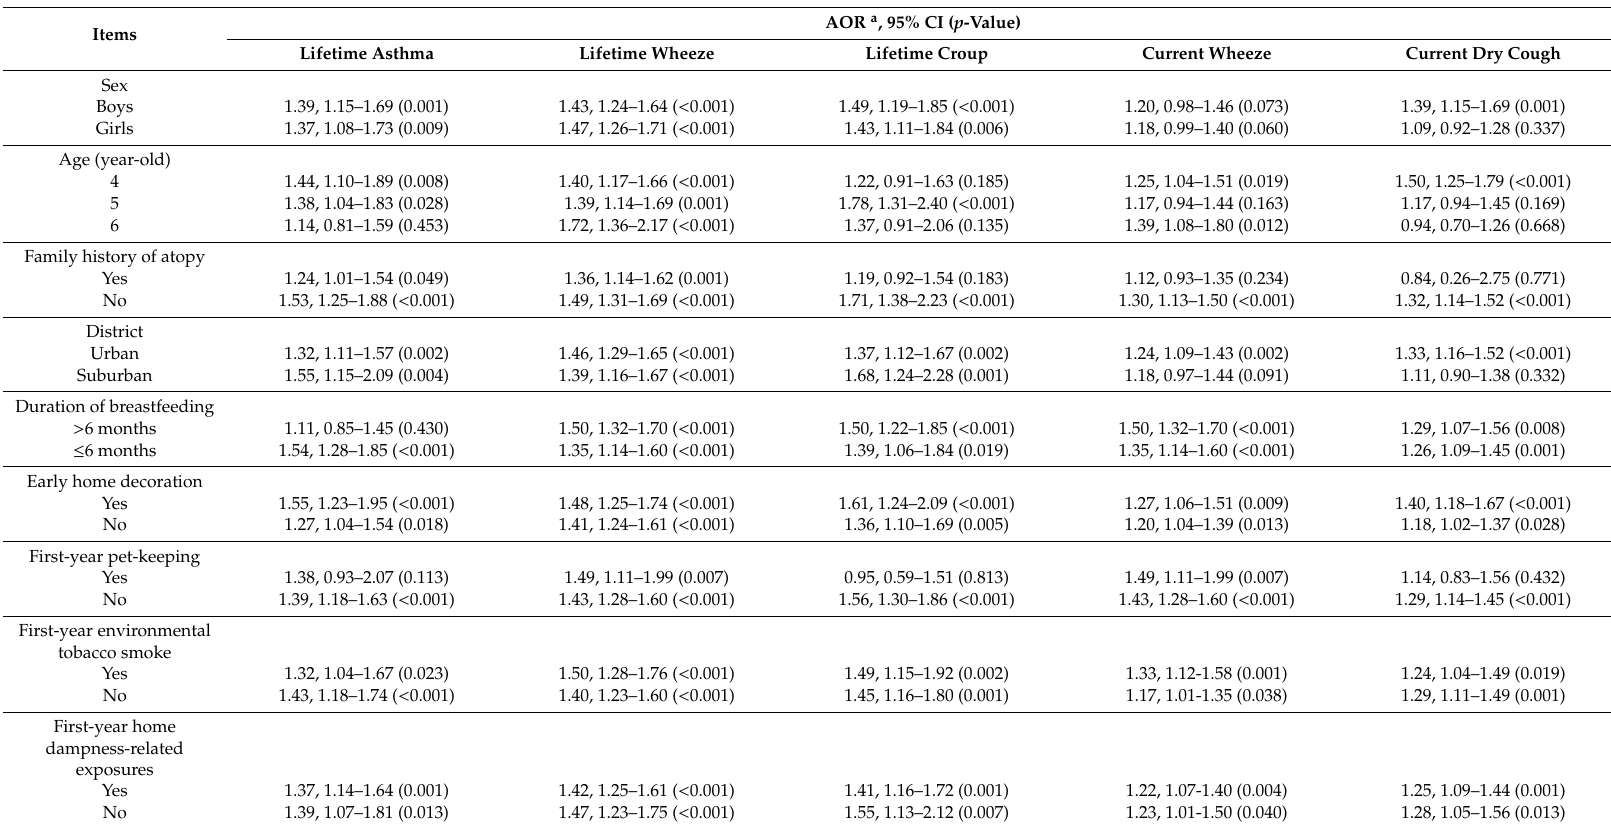
Table 6. Associations of first-year antibiotics exposure with asthma, wheeze, and dry cough in